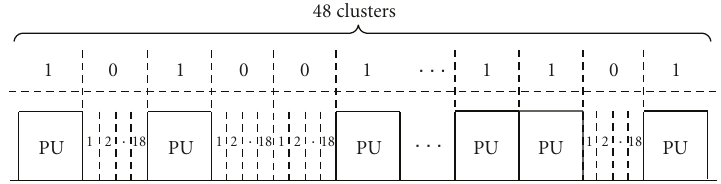
Figure 2: Distributions of the primary users and the spectrum holes with “ N all = 48” and L=18 .